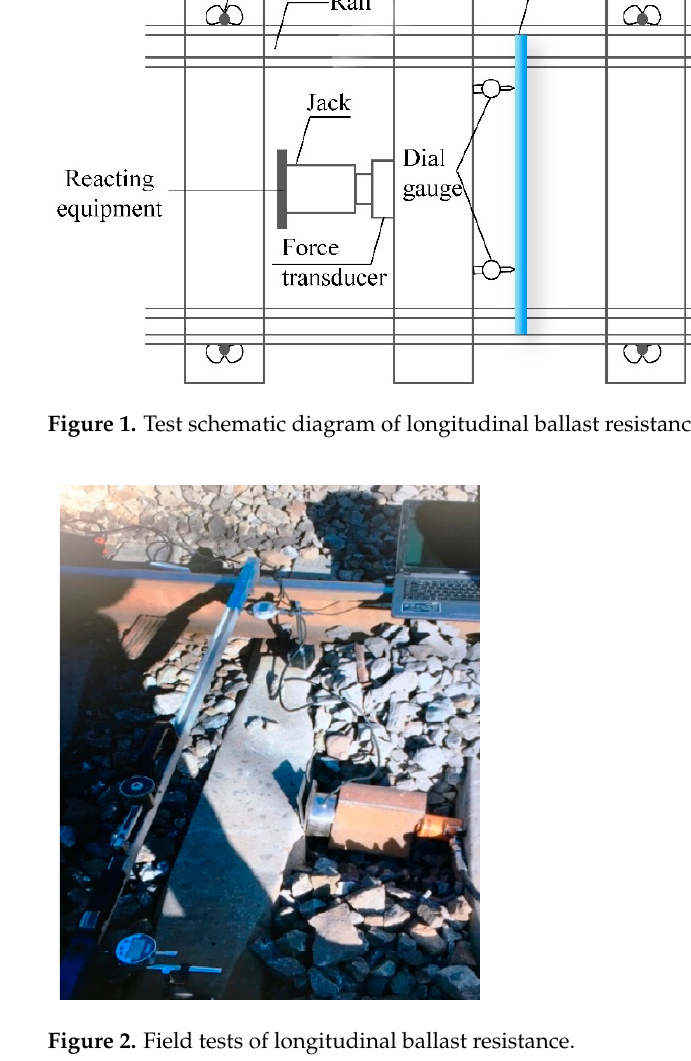
Figure 2. Field tests of longitudinal ballast resistance.